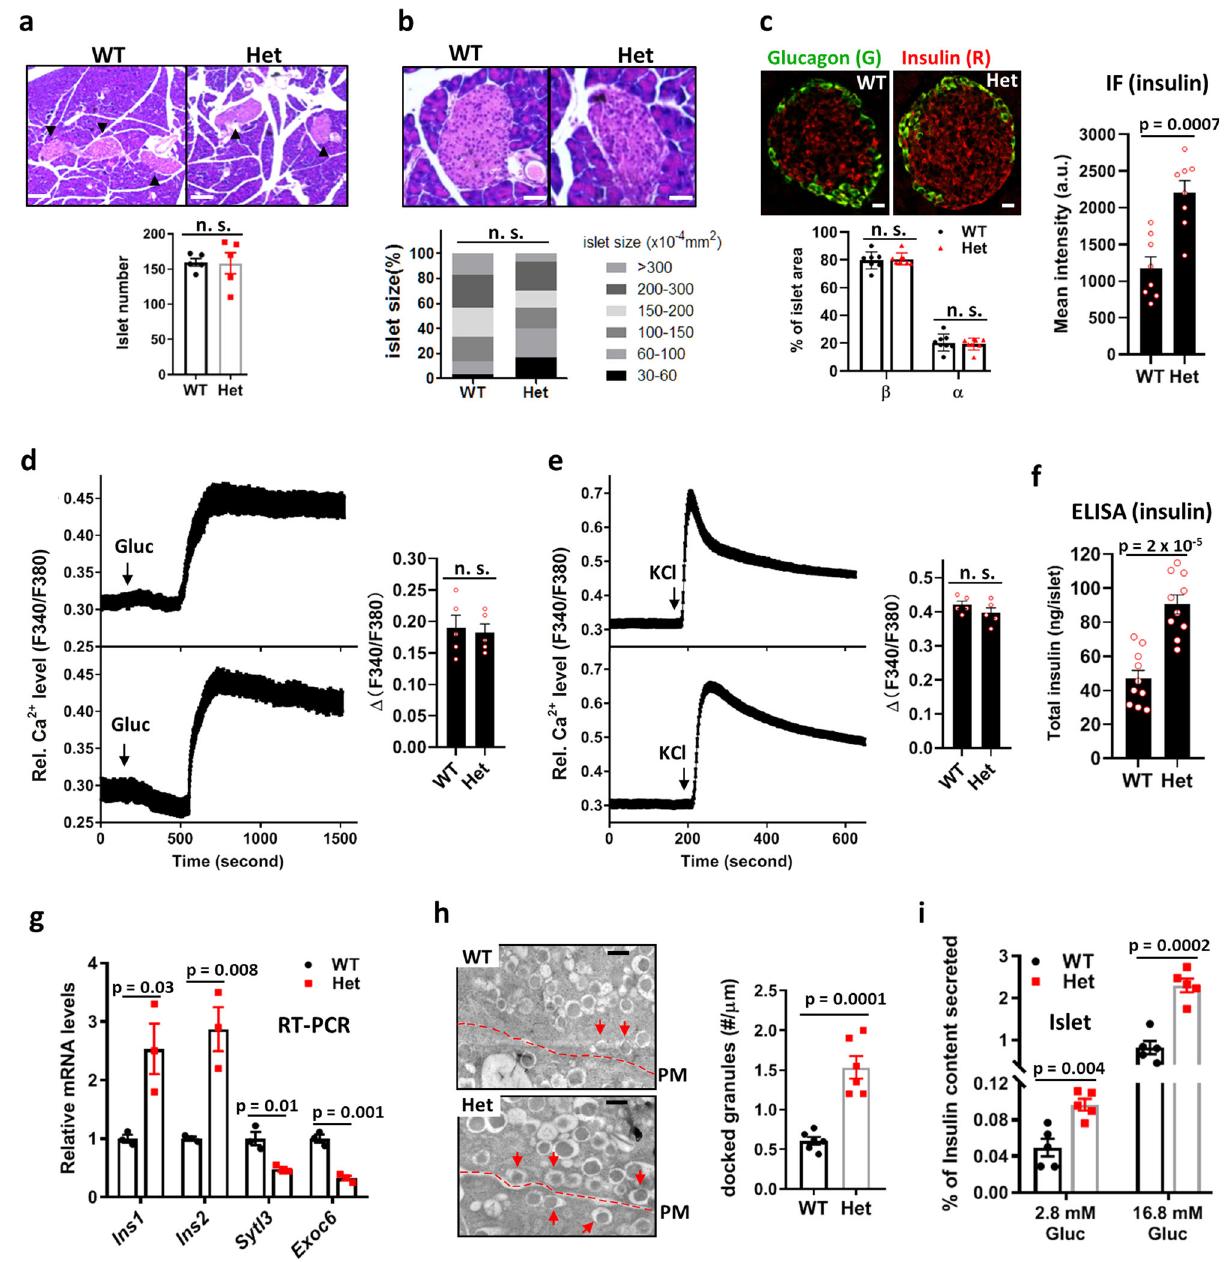
Fig. 2 Increased insulin production and vesicle release contribute to hyperinsulinemia in Csn2 WT/K70E (Het) mice. a , b H&E staining-based morphometric analysis of pancreatic islets from wild-type and Csn2 WT/K70E mice. Number of islets per pancreas ( a ) and average islet area ( b ) was measured by examining 20 slides with every fi ve slides in between, covering the whole pancreas ( n = 5, n.s. not signi fi cant). Data are presented as mean ± SEM. Scare bars, 1.5 μ m ( a ) and 0.4 μ m ( b ). c Immuno fl uorescence staining of insulin and glucagon in pancreatic islets from wild-type and Csn2 WT/K70E mice. Scare bars, 0.2 μ m. Lower panel: percentage of α or β cells in an islet is measured based on the area of green (anti-glucagon, α cells) and red fl uorescence (anti-insulin, β cells; n = 8, n.s. not signi fi cant). Data are presented as mean ± SEM. Right panel: quanti fi cation of the immuno fl uorescence intensity of insulin staining ( n = 8). P values were calculated by two-tailed Student ’ s t test. d , e Average islet cytoplasmic Ca 2 + responses to depolarization induced by 20 mM glucose ( d ) or 25 mM KCl ( e ), assayed with Fura2AM ( n = 5, n.s. not signi fi cant). Data are presented as mean ± SEM. f Total insulin content of pancreatic islet measured using ELISA assay ( n = 10). P values were calculated by two-tailed Student ’ s t test. g Levels of Ins1 , Ins2, Sytl3 , and Exoc6 transcripts from pancreas measured by real-time PCR ( n = 10). Data are presented as mean ± SEM. P values were calculated by two-tailed Student ’ s t test. h Representative electron micrographs of pancreatic islets showing β cell insulin granules. Dotted lines: plasma membrane (PM). Docked granules are marked by arrow heads. Scale bars, 0.5 μ m ( n = 6). Data are presented as mean ± SEM. P values were calculated by two-tailed Student ’ s t test. i GSIS of wild-type and Het islets measured as percentage of insulin secretion. Islets were lysed after GSIS to determine total insulin content ( n = 5). Data are presented as mean ± SEM. P values were calculated by two-tailed Student ’ s t